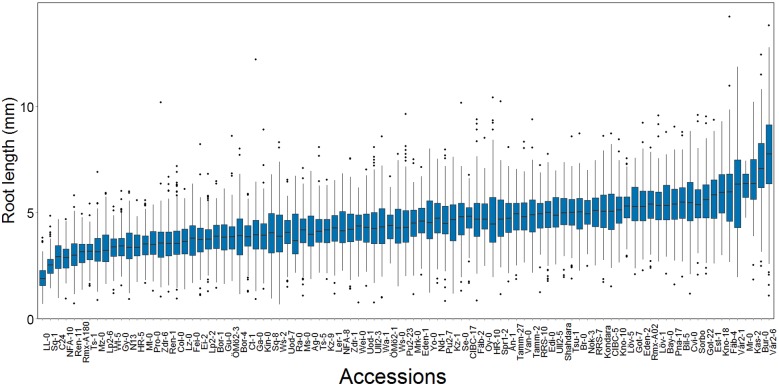
The distributions of within-accession root length mean and variance in a sample of 93 natural A. thaliana accessions.There is a large dispersion of the root length mean at day seven among the accessions (n = 3 x 70 dark grown seedlings / genotype).